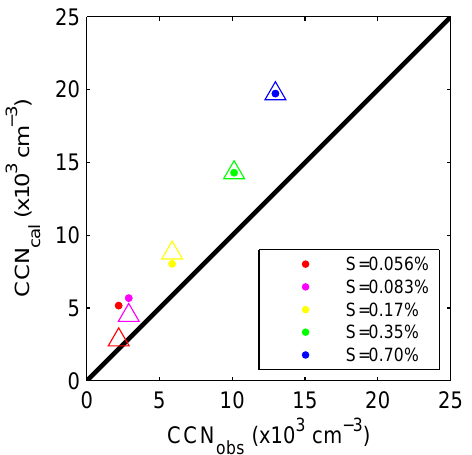
Fig. 5. Growth curves of four selected bins at each supersatura- tion ( S ): the smallest bin of aerosols (bin 1), the largest bin of aerosols (bin 110), the smallest bin of aerosols that can be consid- ered as CCN based on the kinetic model (dashed black lines; bin 66 at S = 0 . 056%, bin 64 at S = 0 . 083%, bin 57 at S = 0 . 17%, bin 42 at S = 0 . 35%, bin 29 at S = 0 . 70%) and the smallest bin of aerosols that can be considered as CCN based on the equilib- rium model (solid gray lines: bin 75 for S = 0 . 056%, bin 68 for S = 0 . 083%, bin 55 for 0.17%, bin 42 for S = 0 . 35%, bin 29 for S = 0 . 70%). A particle is considered as CCN if its radius is larger than 0.5µm (red dashed line) at 10s using the kinetic model. The initial radii of selected bins and the time for these bins to grow to a detectable size can be seen in Table 2. The composition of aerosols is pure ammonium sulfate and the water accommodation coefficient is